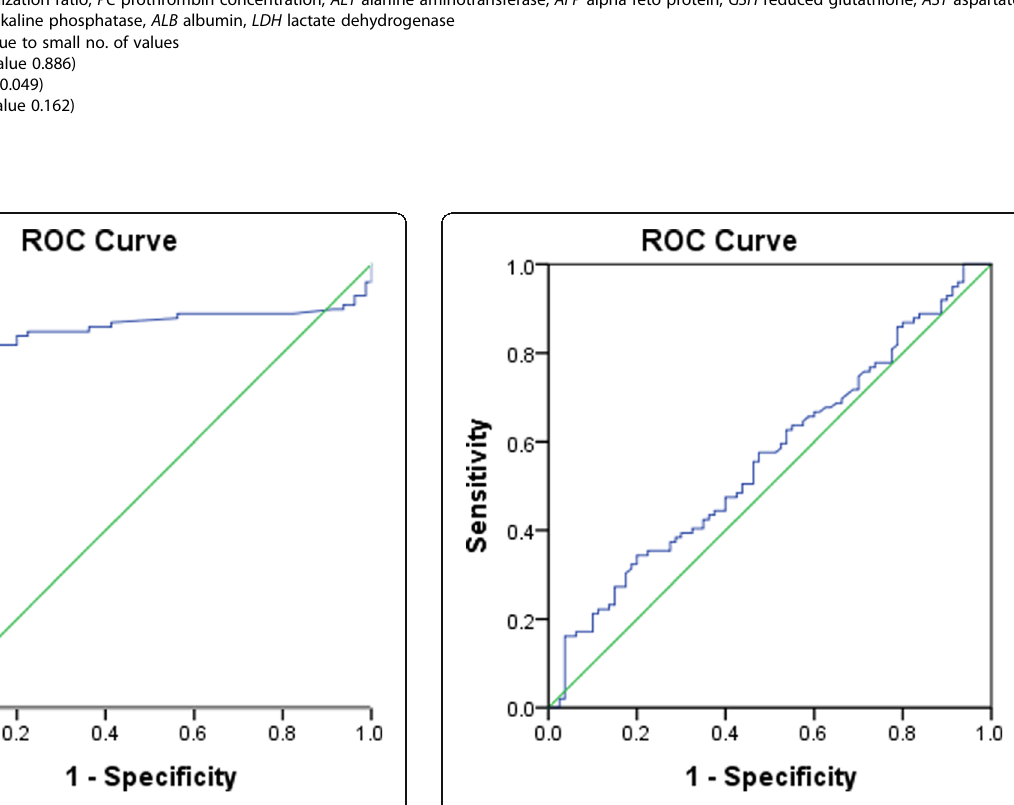
Fig. 4 Roc curve analysis of plasma GSH showing the best cutoff value to differentiate between the HCC and normal control groups. Area under the curve (AUC) was